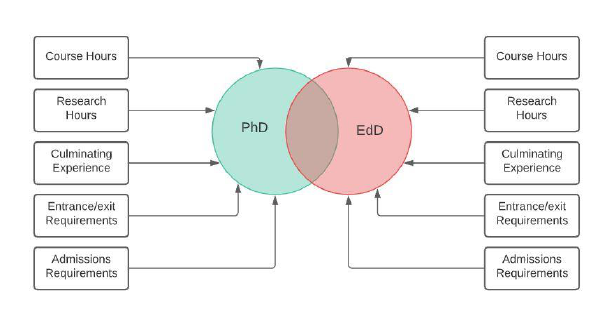
Figure 1. Concept Framework